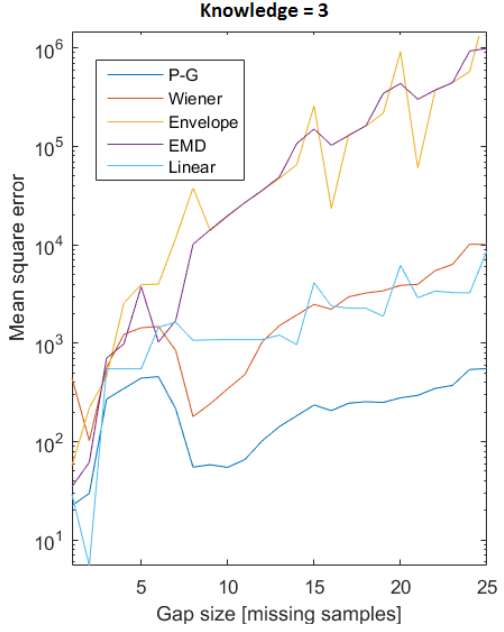
Figure 8. Frequency comparison of the reconstruction